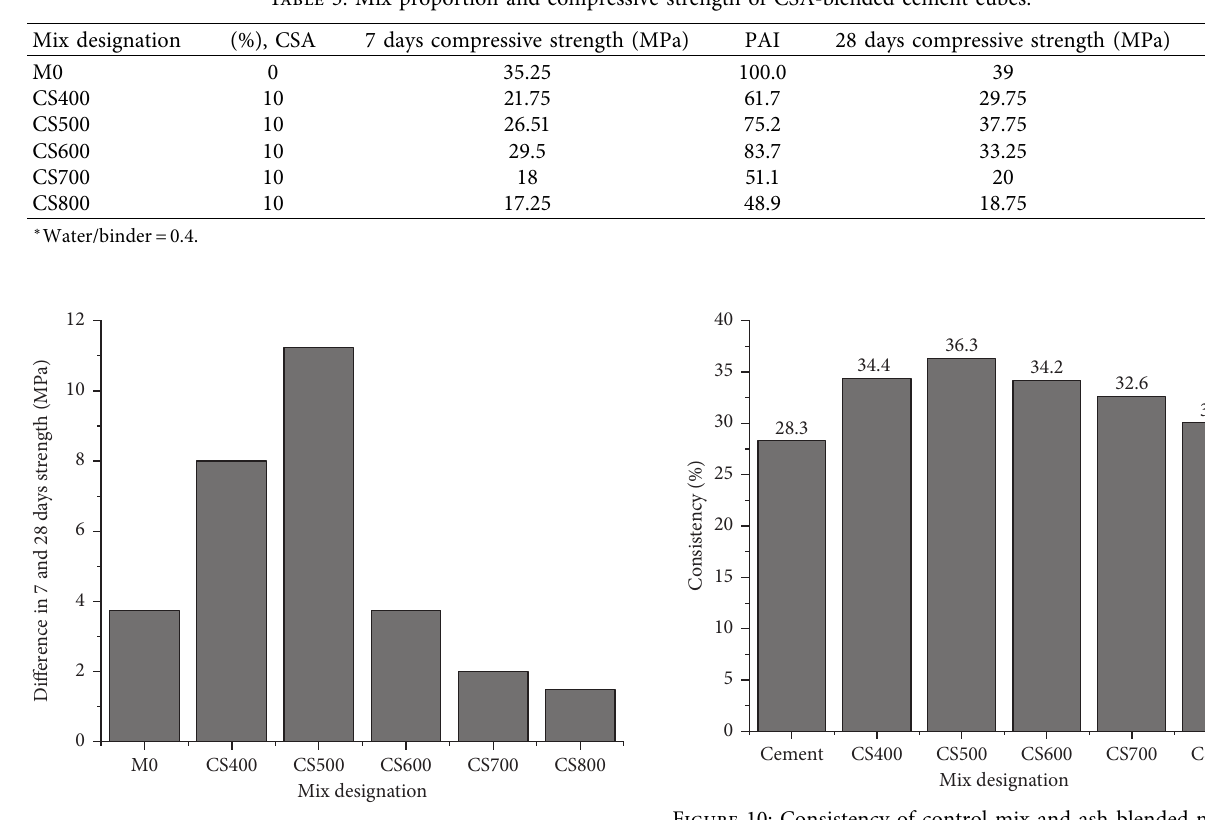
Figure 9: Difference in compressive strength at 7 and 28 days.